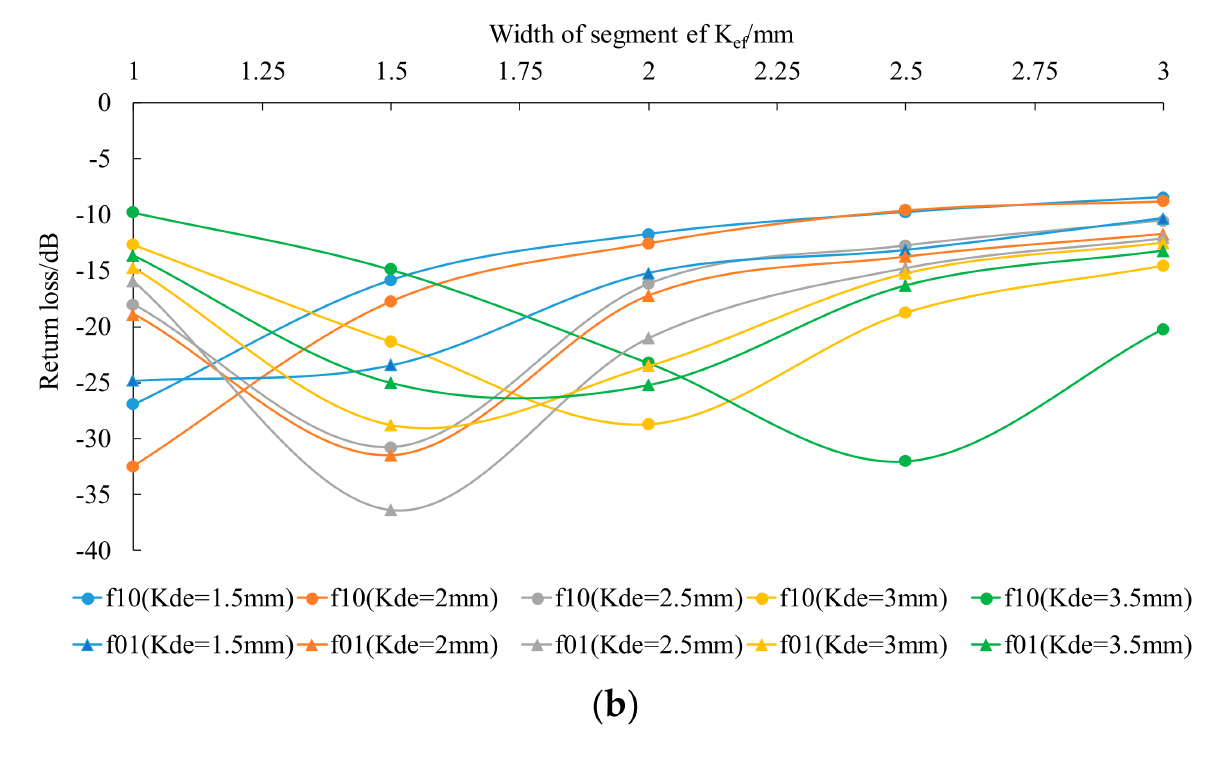
Figure 9. Simulation results for feeding line width optimization; ( a ) segment ab and segment bc: optimized simulation results; ( b ) segment de and segment ef: optimized simulation